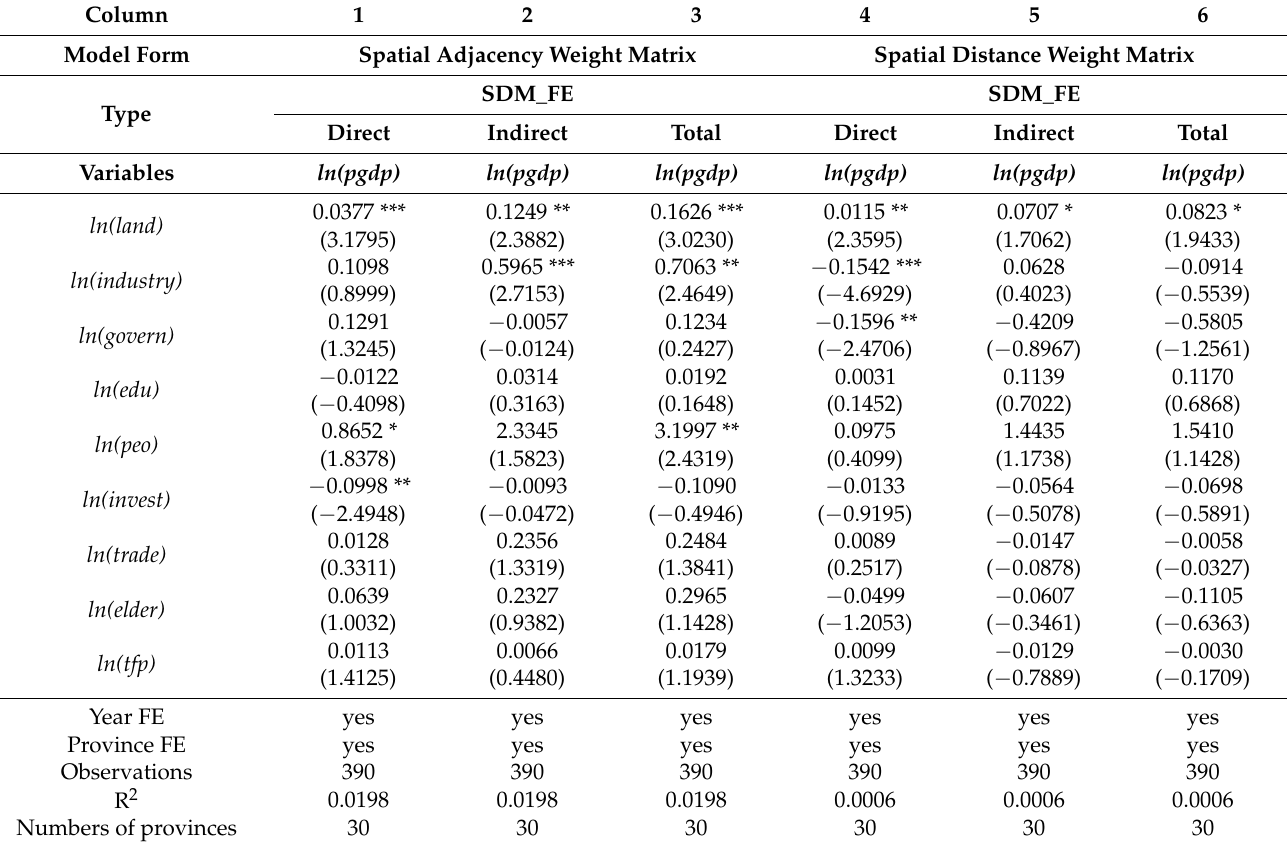
Table 2. Direct effect, indirect effect, and total effect of the spatial Durbin